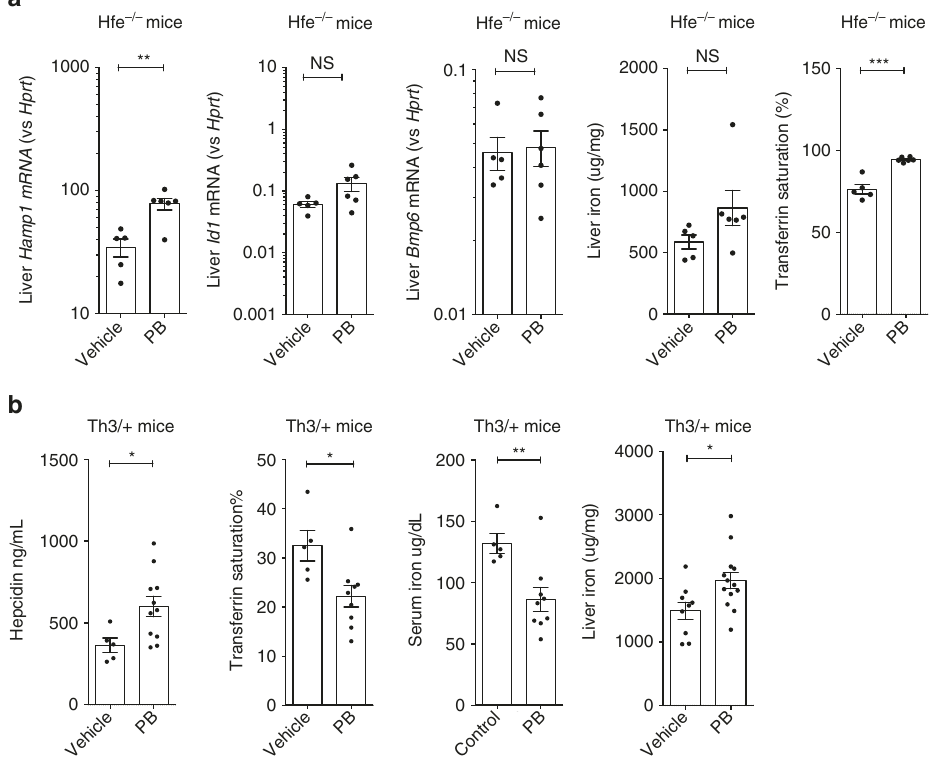
Fig. 5 Effects of Panobinostat on hepcidin in disease models of iron overload. a Effects of 3 days 20 mg/kg/d i.p. PB vs control on 15-week-old HFE − / − on liver Hamp1 mRNA, Id1 mRNA, and Bmp6 mRNA expression; liver non-heme iron content, and transferrin saturation. b Effects of Panobinostat 5 mg/kg/d for 7 days on 8 – 24-week-old Hbb Th3/+ (Th3/+) mice on serum hepcidin levels, transferrin saturation, serum iron, and liver non-heme iron